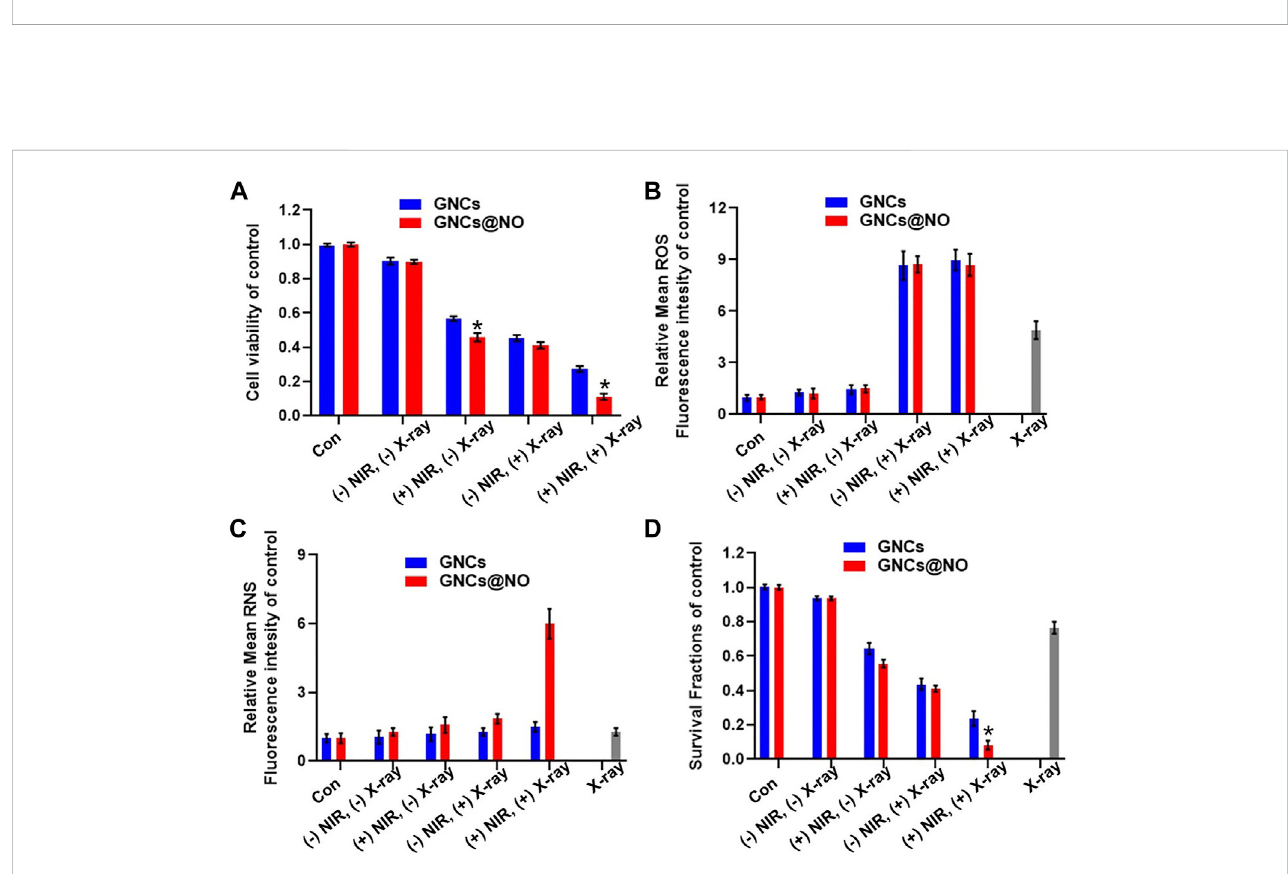
FIGURE 3 Combined GNCs@NO therapies in vitro . (A) Viability of MCF-7 cells after incubation with GNCs or GNCs@NO with (+) or without (-) NIR or/and X-ray irradiation, * p < 0.05 versus GNCgroup. (B) Quantitativeanalysis ofROSproduction byFACS. (C) Quantitativeanalysis ofRNSproductionbyFACS. (D) Colony formation assay of MCF-7 cells for various treatments, * p < 0.05 versus GNC group. The values represent mean values ±SD, n =